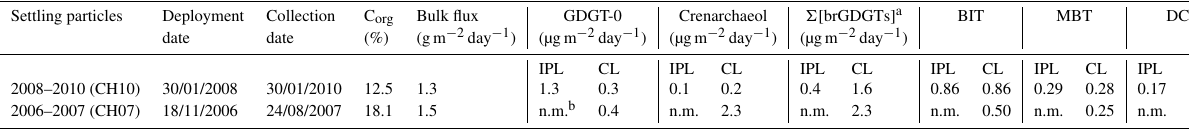
Table 2. Fluxes and indices of GDGTs in settling particles throughout the estimated deposition periods of CH10 and CH07 surface sediments. GDGT data from 18 November 2006 to 1 December 2007 are collated from Sinninghe Damsté et al. (2009) and those from 31 December 2007 to 31 August 2010 are collated from Buckles et al. (2014). Settling particles